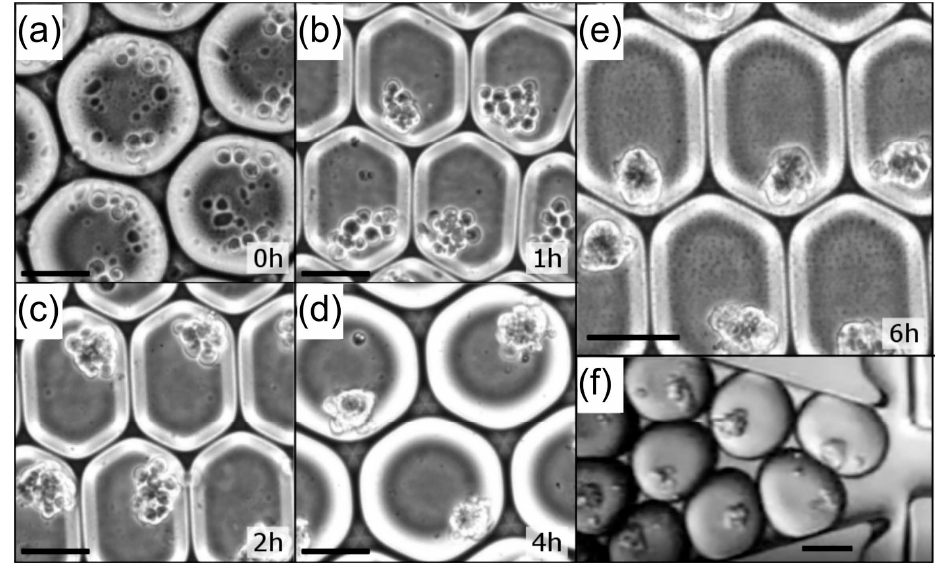
Figure 8. Formation of P19 EC (an average of 12 cells) aggregates into 110 μ m (700 pL) droplets. Condensation of P19 EC cells over time in microfluidic droplets: ( a ) just after encapsulation; ( b ) 1 h; ( c ) 2 h; ( d ) 4 h and ( e ) 6 h incubation after encapsulation; ( f ) Those aggregates can then be re-injected to be combined with monoclonal droplets. Scale bars represent 50 μ m.